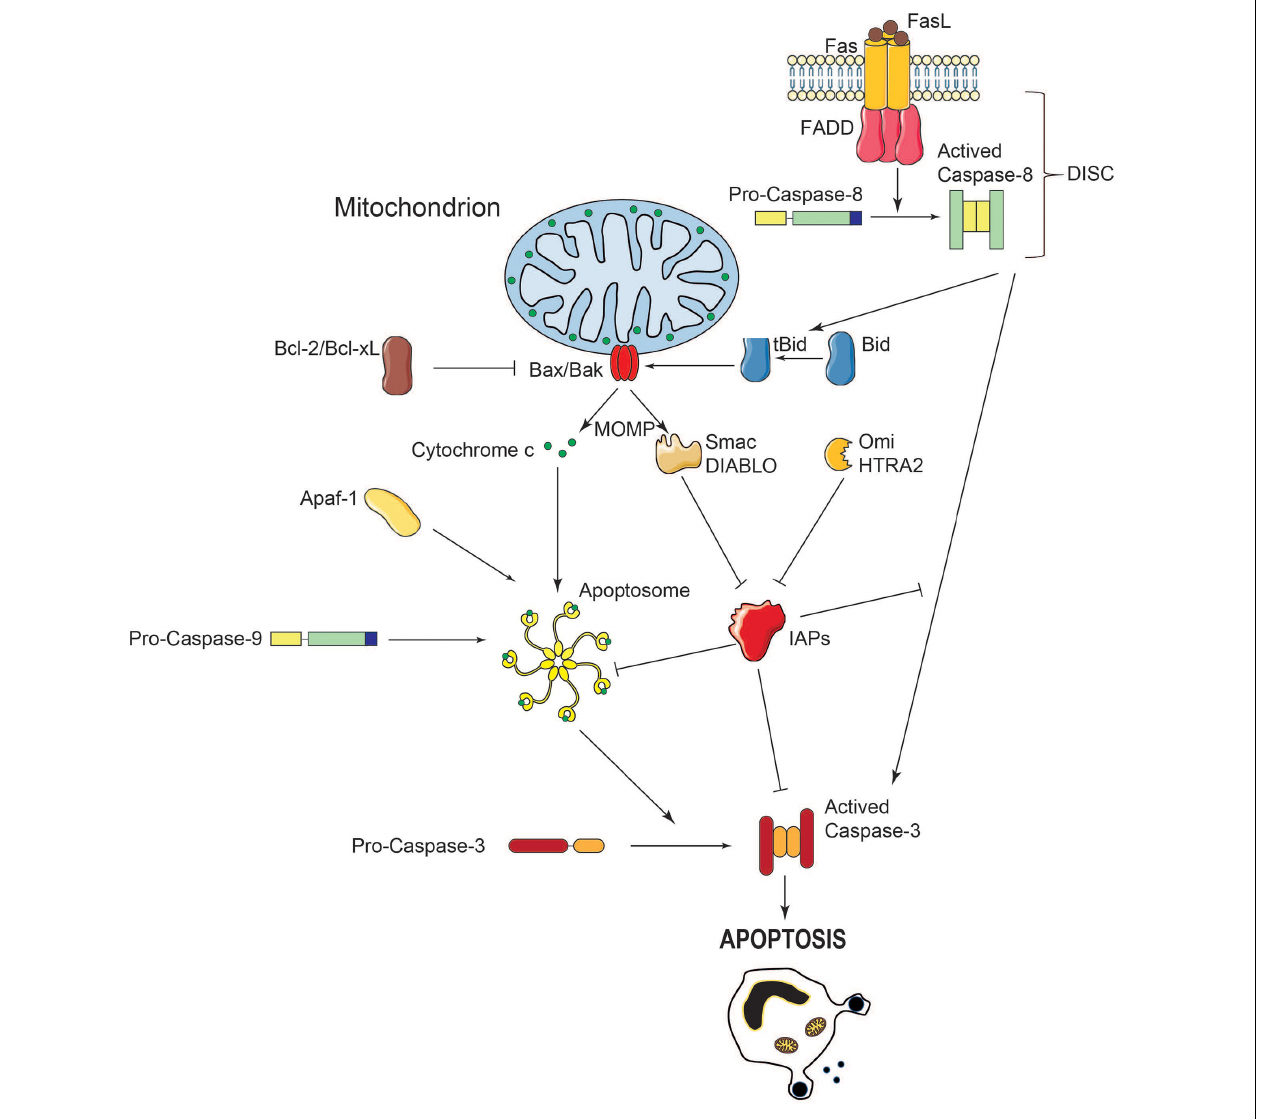
FIGURE 2 | Schematic representation of caspase activation and regulation during MOMP. During apoptosis, the MOM is permeabilized, leading to the release of pro-apoptotic molecules into the cytosol. When released in the cytosol, cytochrome c interacts with the adaptor protein Apaf-1 in presence of ATP. A